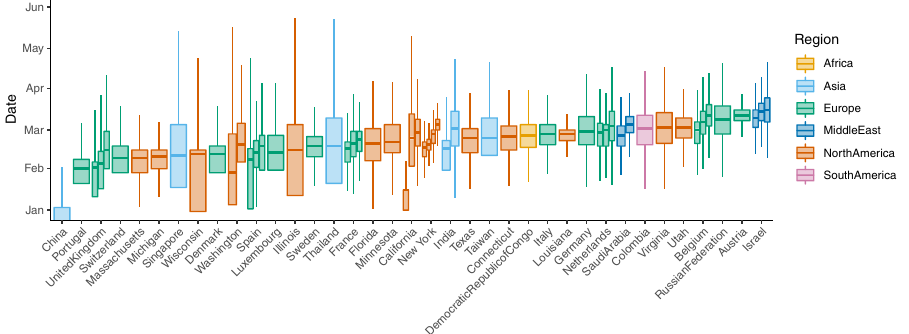
Fig. 2 Distribution of phylogenetically inferred times of importation events for the 57 sites included in our analysis, also referred to as seeding time. Ancestral states are reconstructed onto the phylogeny as exogenous or within the region of interest. The midpoint between an ancestral node which is exogenous to the region of interest and a node which is within the region of interest is the time of importation. Local epidemics can be seeded by many importation events. Central box-plot lines represent the central epidemic seeding time (CEST). Note that the CEST does not represent the earliest viral introduction but rather the mean time of viral introduction weighted by the number of samples descended from each viral introduction. Boxes represent the interquartile range of the distribution and whiskers indicate the 25th and 75th percentiles of the distributions, derived from n = 2500 data points (100 time-resolved phylogenies for each location, with ancestral states reconstructed 25 times on each). Ranges re fl ect the distribution of importation dates, rather than uncertainty around an estimate of seeding times. Sites from the same country or US state are grouped together and sites are ordered based on the fi rst CEST for that country or US state. Width serves only to compress multiple sites from the same country or US state. ( p < 0.0001; Fig. 3, Supplementary Fig 5) and the univariate applied a skygrowth model 16,17 (version 0.3.1) to estimate viral regression ( R 2 = 0.32, p < 0.0001; Fig. 4, Supplementary Table 1). effective population size through time and growth rates of effective population size. Under appropriate conditions, effective An additional 14 days of transmission before maximum NPI was population size can be used as a proxy statistic for epidemic associated with a 2.18-fold (95% CI: 1.52 – 3.13) increase in prevalence 7 . Viral effective population size at maximum NPI was effective population size at time of maximum NPI in the Deming similarly associated with time to maximum NPI in the Deming model and 2.08-fold (95% CI: 1.54 – 2.83) increase in a univariate